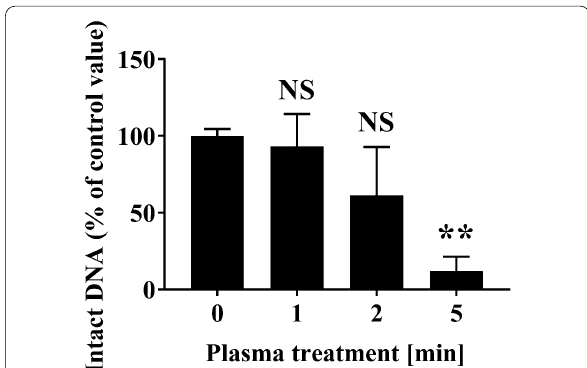
Fig. 3 Changes to fungal DNA (28S rDNA) of Penicillium venetum spotted onto an aluminium plate following APDBD treatment. The level of intact 28S rDNA from P. venetum spotted onto an aluminium plate was quantified by real-time PCR. The level of the corresponding amplified product for the 0 min sample was assigned a value of 100%. Differences where p < 0.01(**) versus Control (0 min) were considered significant when verified by the non-repeated measured ANOVA followed by the Bonferroni correction. NS means no significant difference compared to Control (0 min)